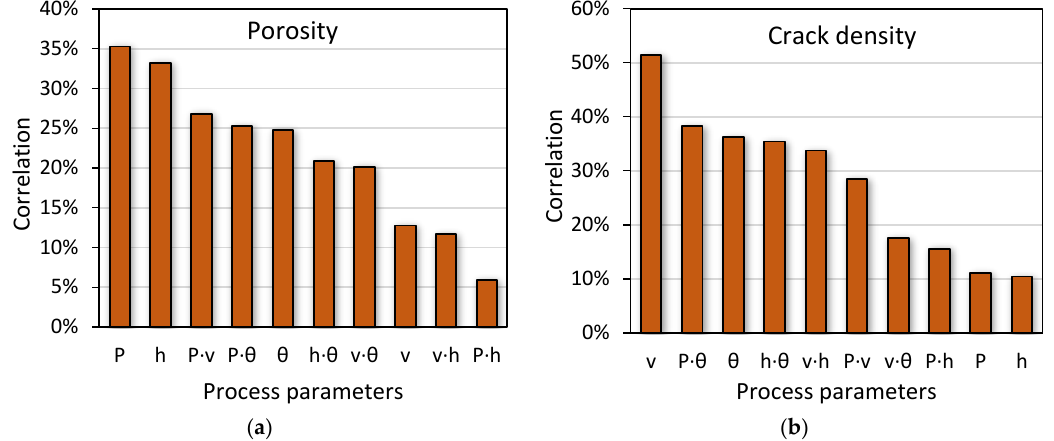
Figure 4. Influences of process parameters on defect formation. ( a ) Porosity; ( b ) cracking.